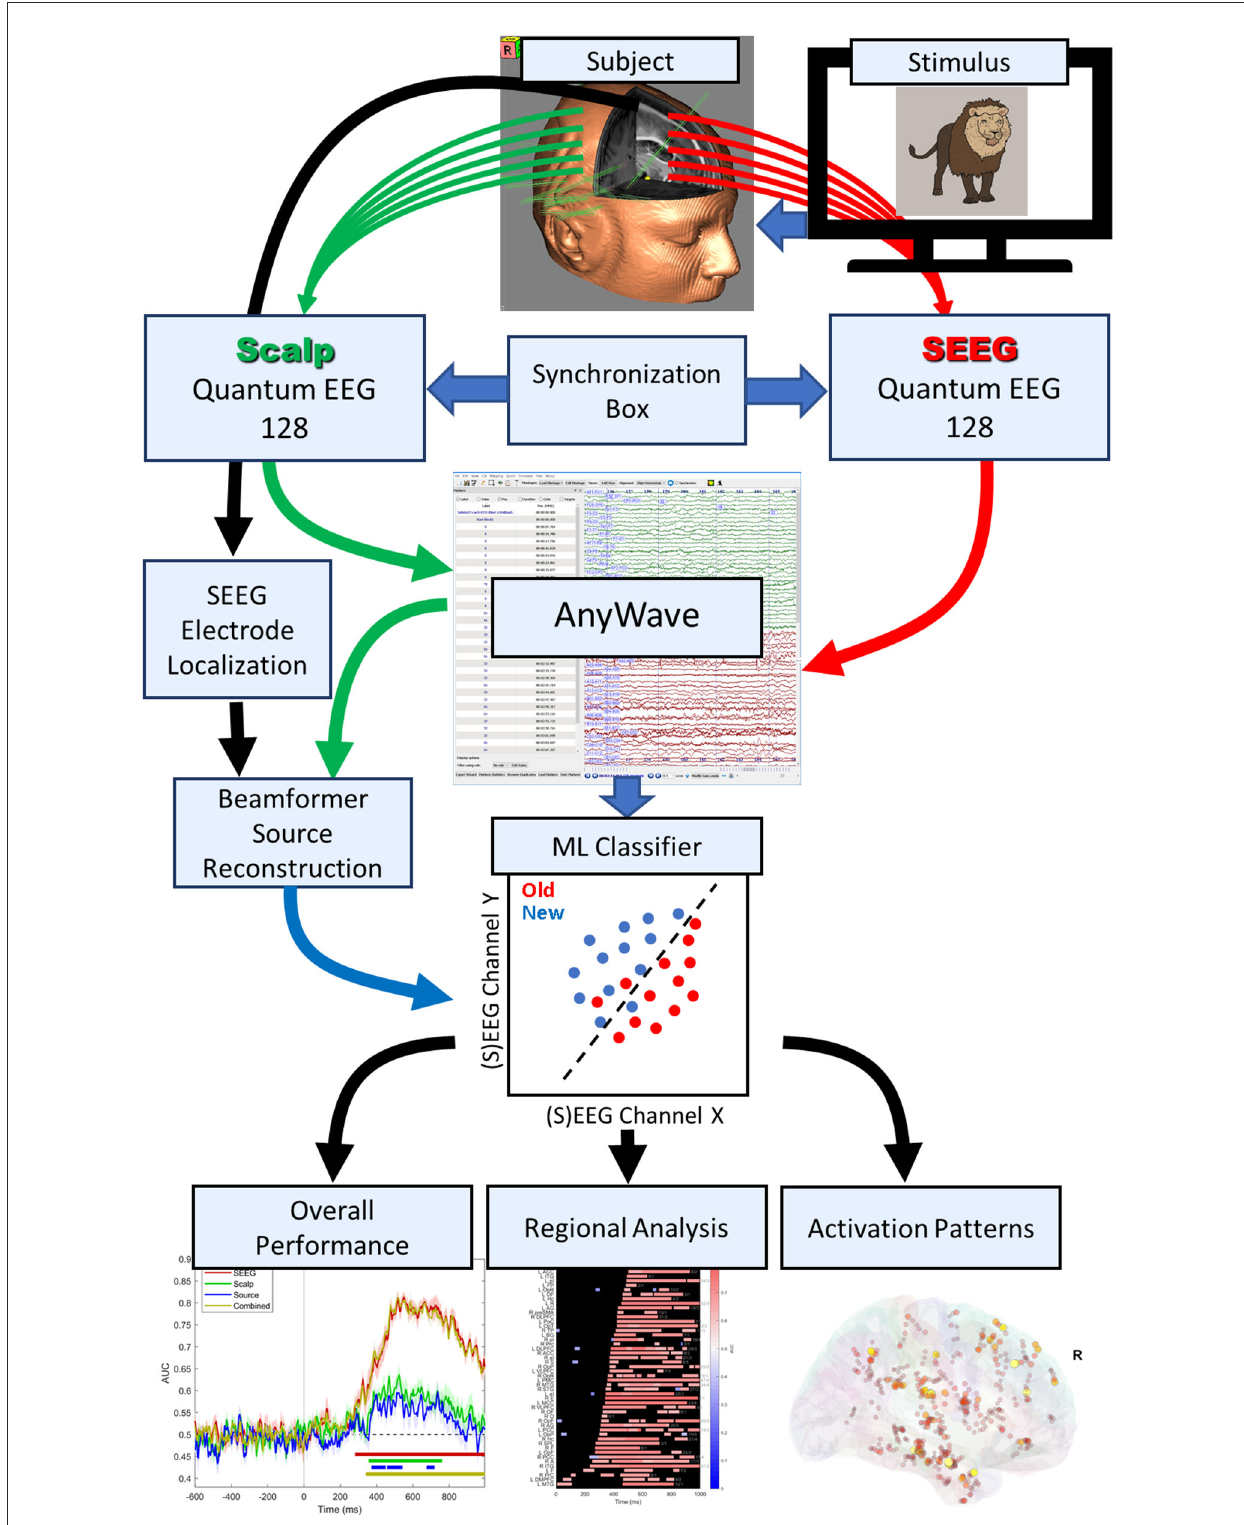
FIGURE1 Signal collection and analysis